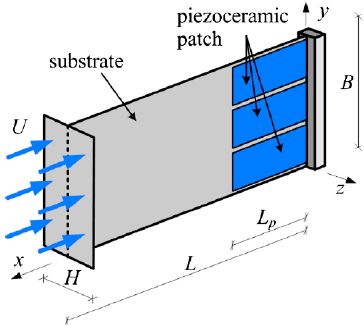
Figure 32. T-shaped airflow fluttering PEH [201].